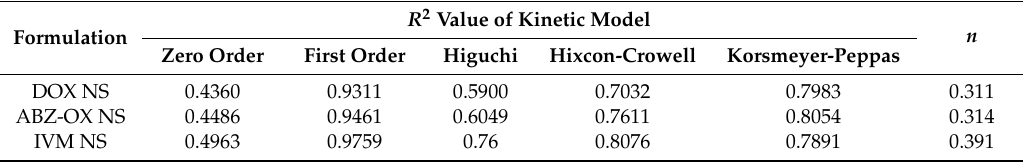
Table 1. Kinetic modelling of DOX, ABZ-OX, and IVM release from NS formulations.